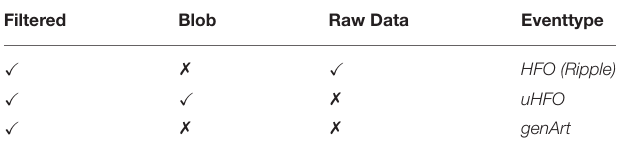
TABLE 3 | Classification criteria and categories of events: Filtered: HFOs visible in High pass filtered data; Blob: isolated Blob visible in DWPD; Raw Data: superimposed activity visible in multi filtered raw data; Eventtype: High frequency oscillation (HFO); unclear high frequency oscillation (uHFO); generic Artifact